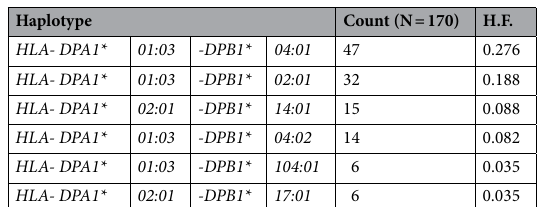
Count (N = 170) H.F.